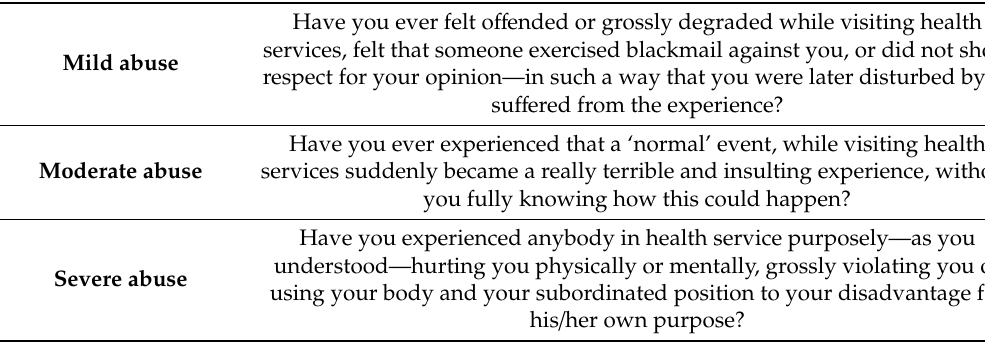
Table 1. Questions about AHC in NorAQ